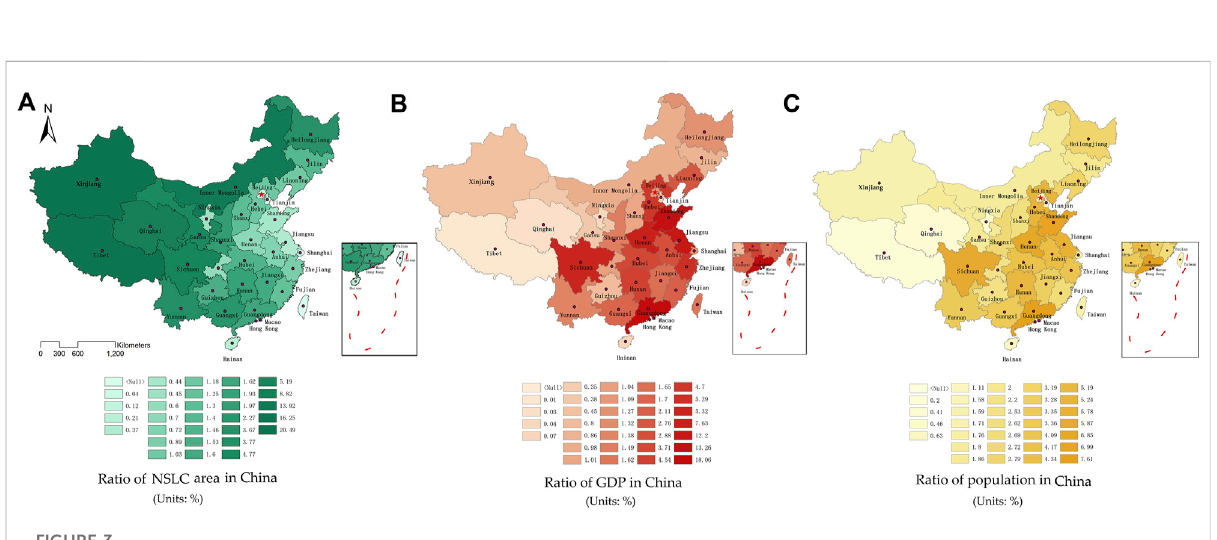
FIGURE 3 Ratio of China ’ s ecological space, GDP and population in